Question: How would you classify this visualization?
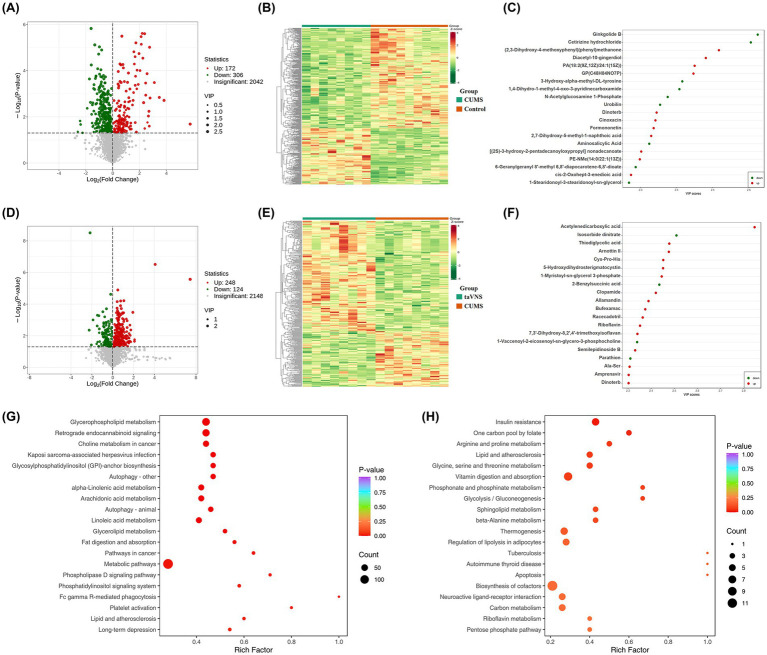
Answer: heatmap